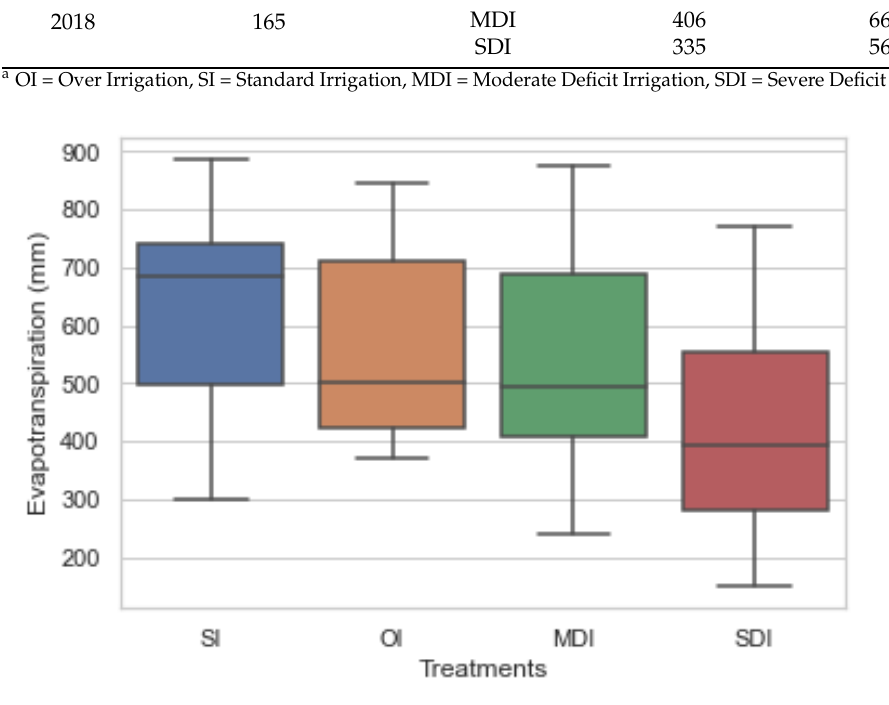
Figure 2. Ranges of seasonal alfalfa ET c for each treatment over five years (2018–2022). Table 4. Seasonal precipitation, irrigation, and alfalfa crop ET (ETc).